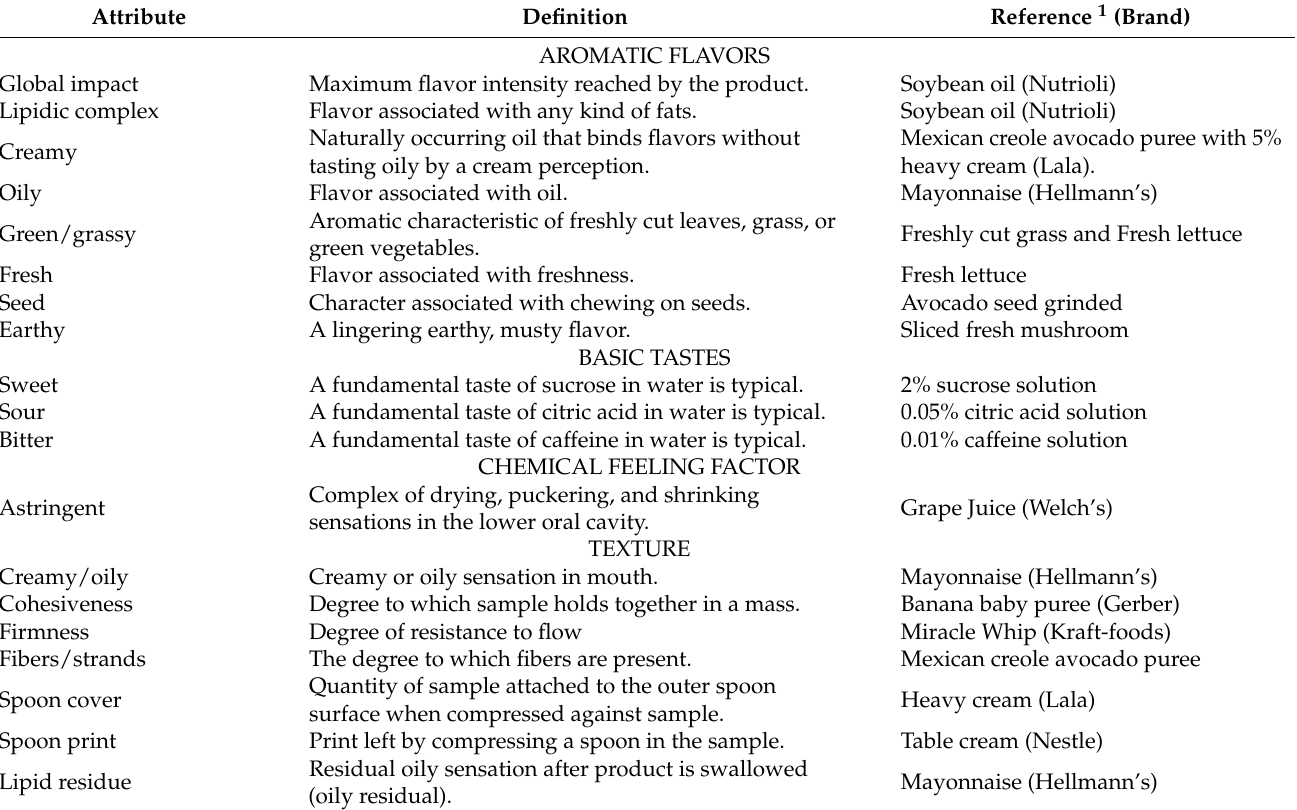
Table 2. Sensory attributes, definitions, and references used in the descriptive analyses of avocado